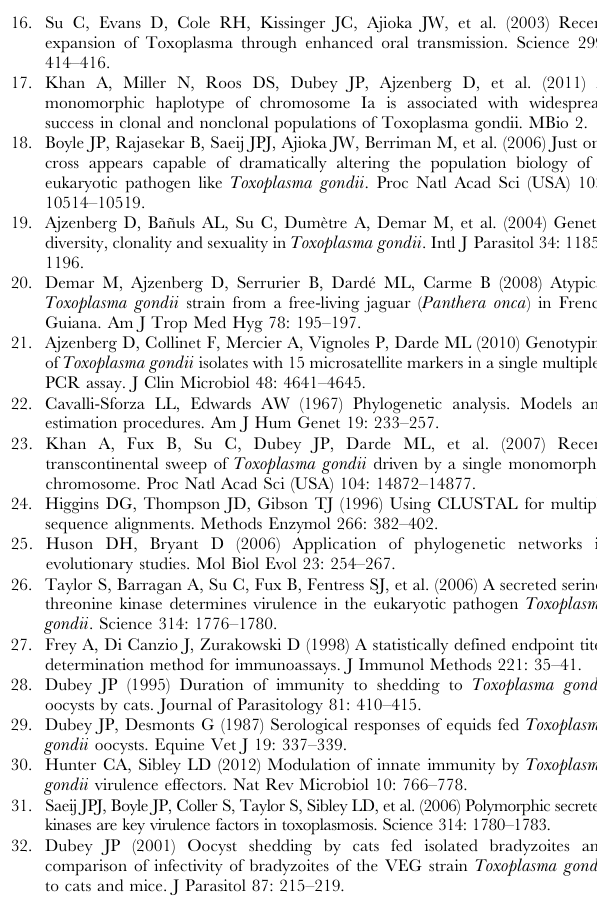
Table S1 Toxoplasma gondii strains used for population genetic